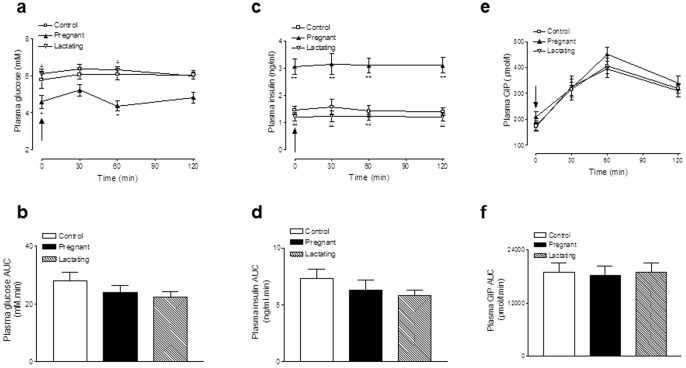
Effects of pregnancy and lactation on (a,b) glycaemic, (c,d) insulin and (e,f) GIP responses to oral fat.Tests were conducted on days 21 and 42 in overnight fasted rats. Oral fat (51.2 kJ/kg body weight) was administered at the time indicated by the arrow. Plasma glucose, insulin and GIP AUC values for 0–120 min are also shown. Values are means ± SEM for 6 rats. * p<0.01 and ** p<0.01 compared to controls. Δ p<0.05 and ΔΔ p<0.01 compared to pregnant rats.